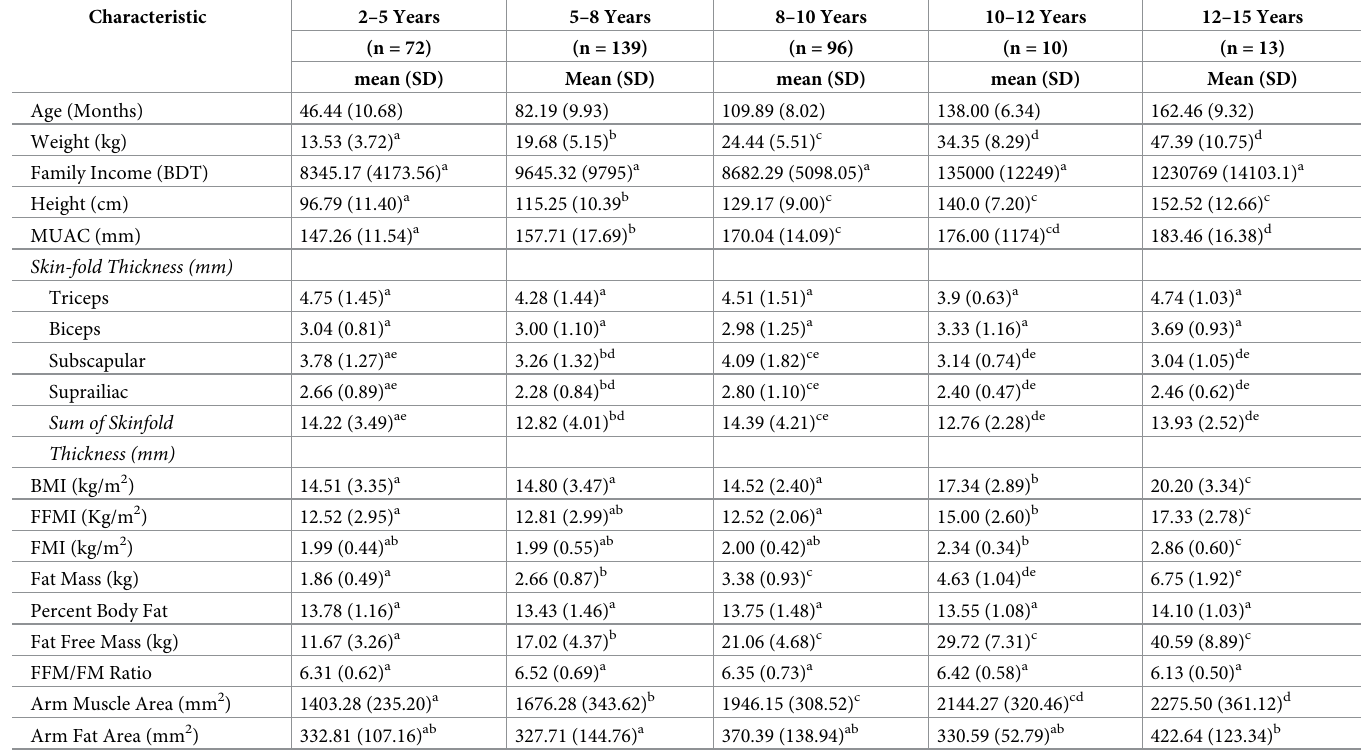
N.B. Each row with different superscript is significantly different, BMI = Body Mass Index, FFMI = Fat Free Mass Index, FMI = Fat Mass Index, MUAC = Mid Upper Arm